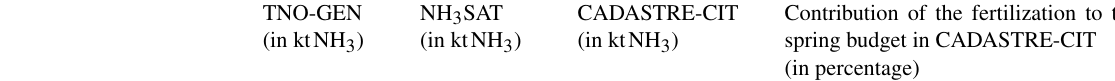
Regions in the northeastern part of France (box A in Fig. 2)